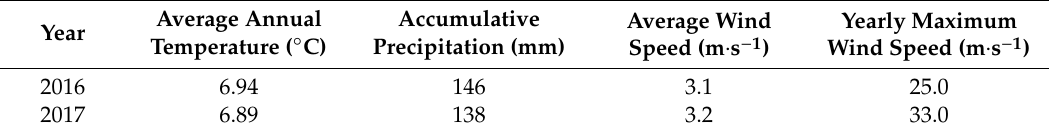
Table 1. Meteorological statistical values in 2016 and